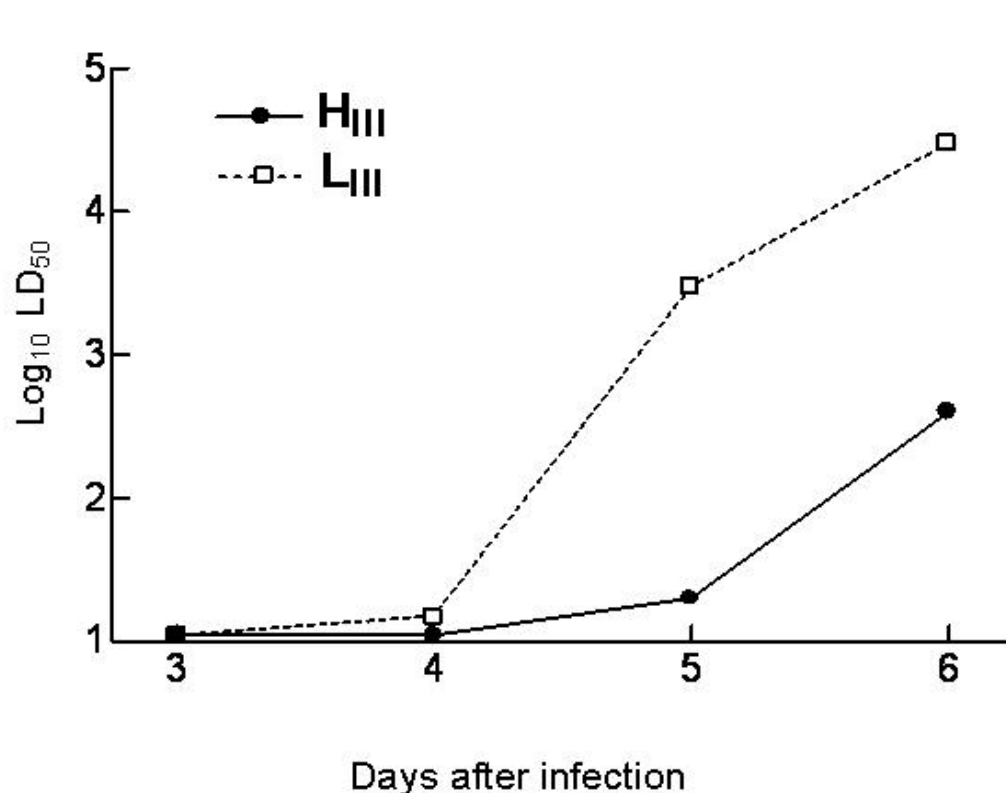
Figure 1. Kinetics of virus replication in the brain of H PV rabies virus strain infection. Animals were intramuscularly infected with 0.1 ml of PV rabies virus (titer of 10 4.9 LD from animals showing rabies symptoms and the virus was titrated by mouse inoculation assay. Data are expressed in Log 3